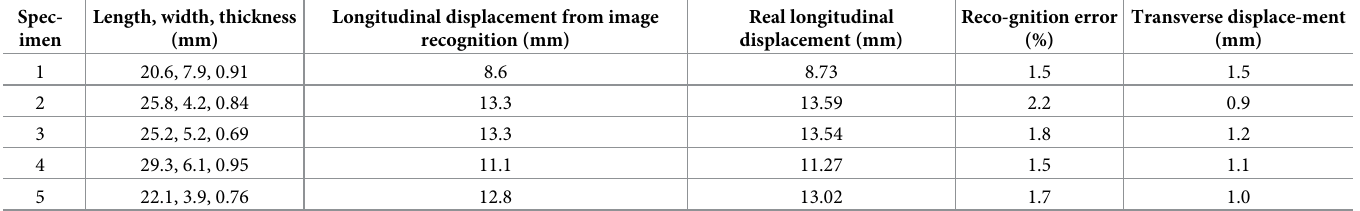
Table 7. Recorded data of Poisson’s ratio measurement test of black fungus leaves. Spec- Length, width, thickness imen (mm)